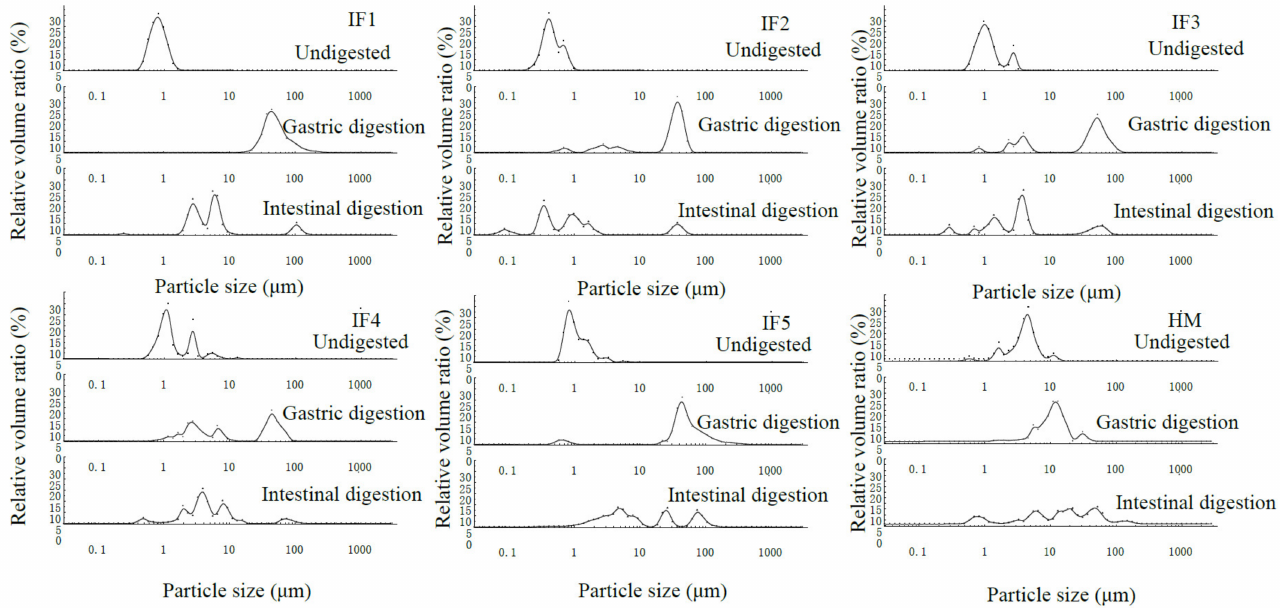
Figure 1. Particle size distribution of fat globules in infant formulas and human milk during diges- tion. IF1: vegetable oil-based formula; IF2: vegetable oil-based formula with MFGM; IF3: bovine milk/vegetable oil-based formula with cream; IF4 bovine milk/vegetable oil-based formula with cream and soybean phospholipid; IF5: whole fat milk power/vegetable oil-based